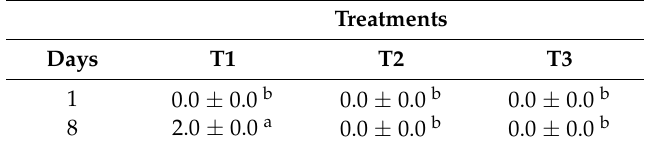
Table 3. The effect of surimi-based coating on melanosis of shrimp during storage at 4 ± 1 ◦ C. Treatments Days